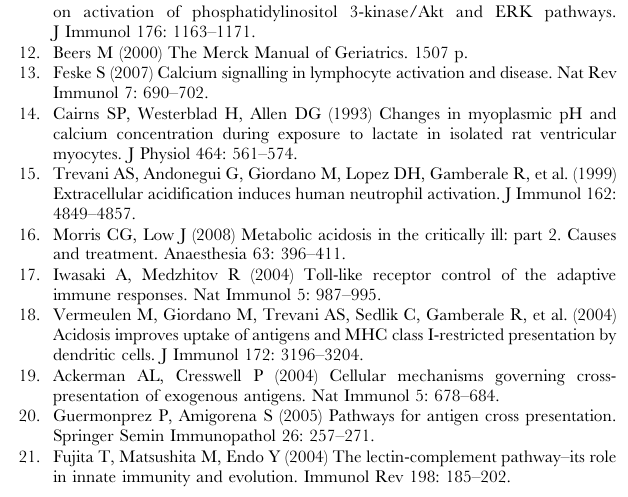
serum in normal